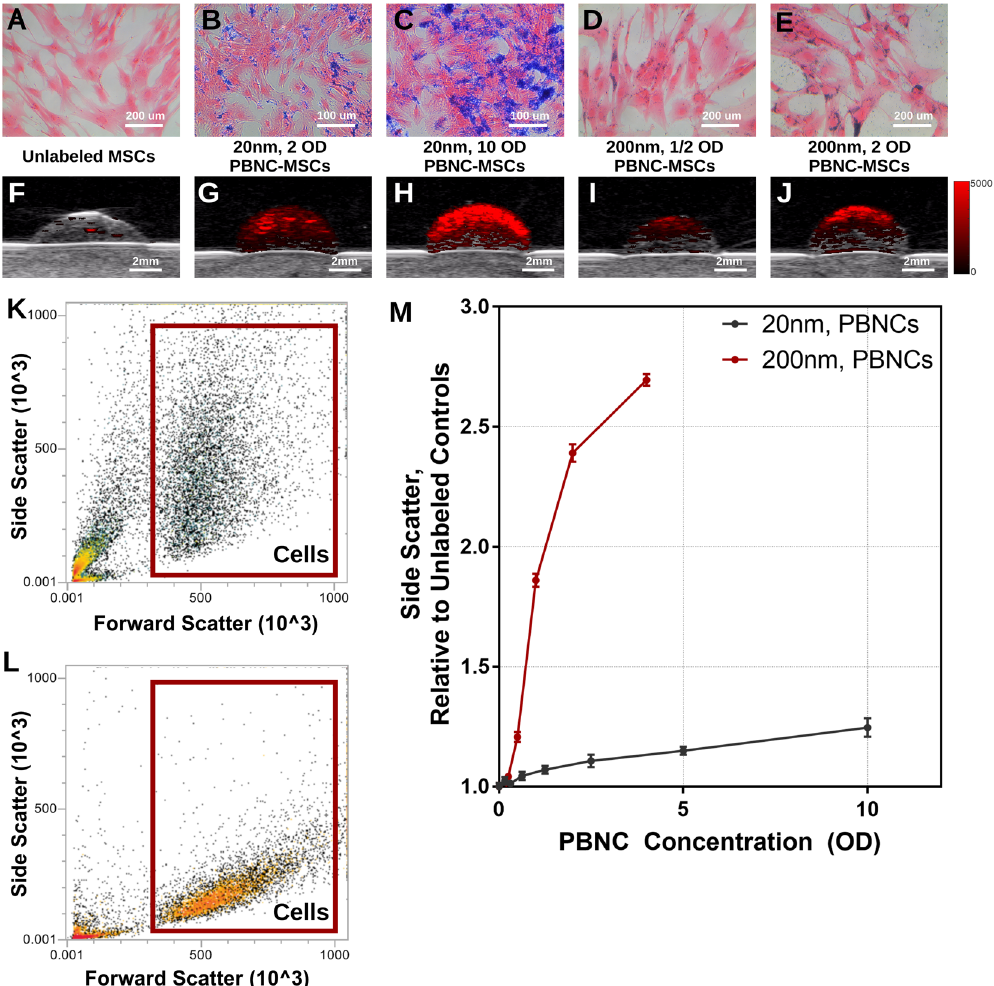
Figure 1. MSCs Take Up PBNCs. (A–E) Representative micrographs (from n = 3 technical replicates of 2 MSC donor strains) of MSCs after incubation with different sizes of PBNCs and in PBNC solutions of different concentrations, as quantified by solution optical density (OD). MSCs were eosin stained to visualize cytoplasm (pink), while PBNCs appeared blue. (F–J) Photoacoustic signal using 690 nm (20 nm PBNCs) or 755 nm (200 nm PBNCs) wavelength, visualizing labelled MSCs in gelatin phantoms. For unlabeled MSCs, signals were minimal for both 690 nm and 755 nm wavelengths, so only the image from 690 nm is shown. (K,L) Uptake of PBNCs was further assessed by light side scatter (SSC). Representative forward scatter (FSC) vs. SSC density maps collected by flow cytometry for (K) MSCs incubated in a solution of 200 nm PBNCs at a concentration of 2 OD or (L) unlabeled MSCs. Gating used for selecting MSCs is shown. (M) Normalized side scatter vs. optical density of PBNC incubating solution for 20 nm and 200 nm PBNC-MSCs (n = 3 technical replicates for each). Error bars denote standard